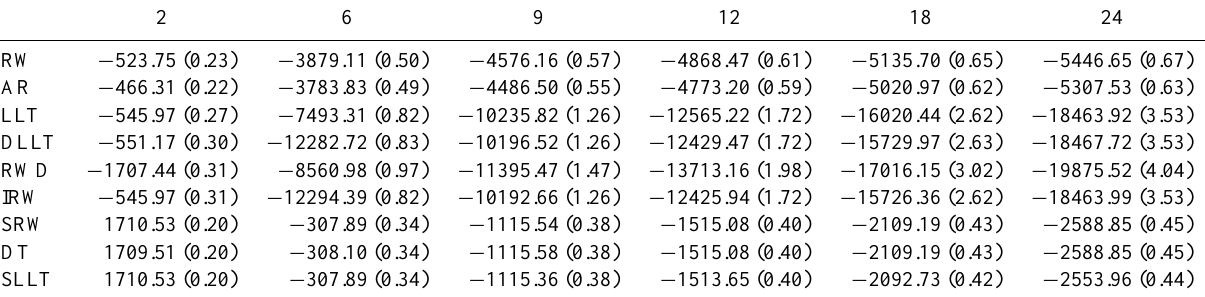
Table 6. Calibration results for Llandrinio showing the log likelihood and RMSE (bracketed) for various forecast lead times (hours) and GRW